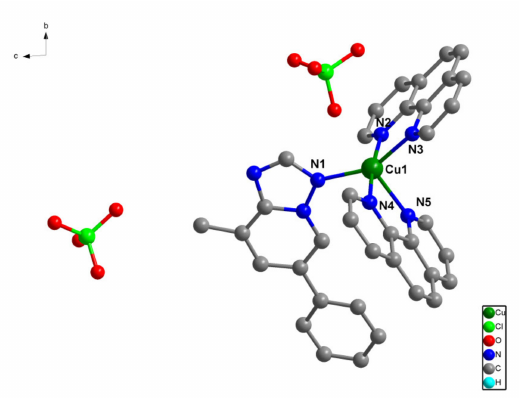
Figure 2. Crystal structure of [Cu(phen) 2 (pmtp)](ClO 4 ) 2 ( 2 ) along a